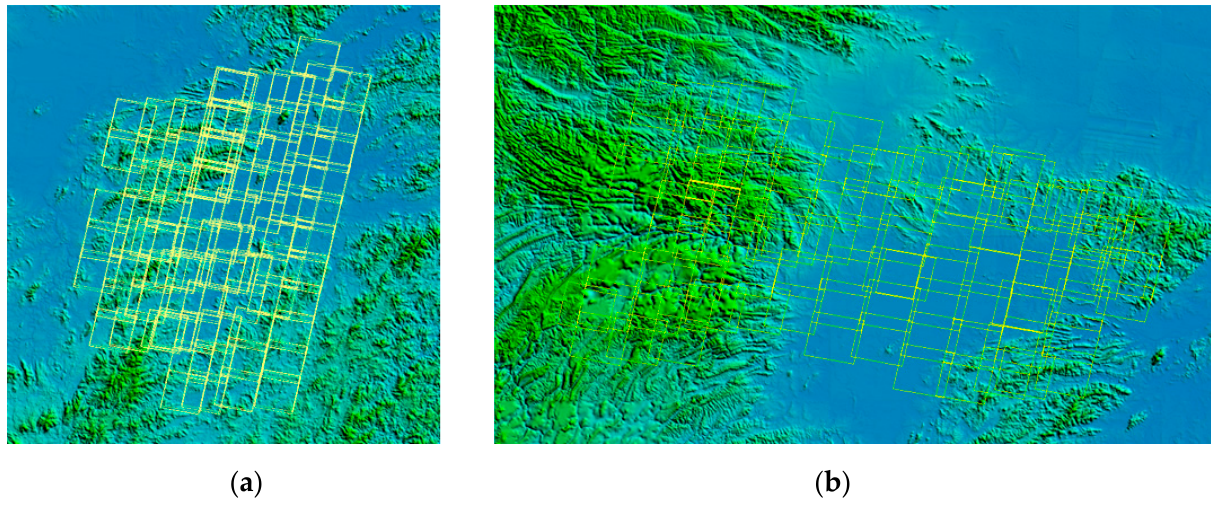
Figure 6. Distribution of Images in Test Area. ( a ) Ziyuan-3 (ZY-3) in Jiangxi Area, ( b ) Mapping Satellite-1 in Hubei Area. Table 1. Basic parameters of test area.